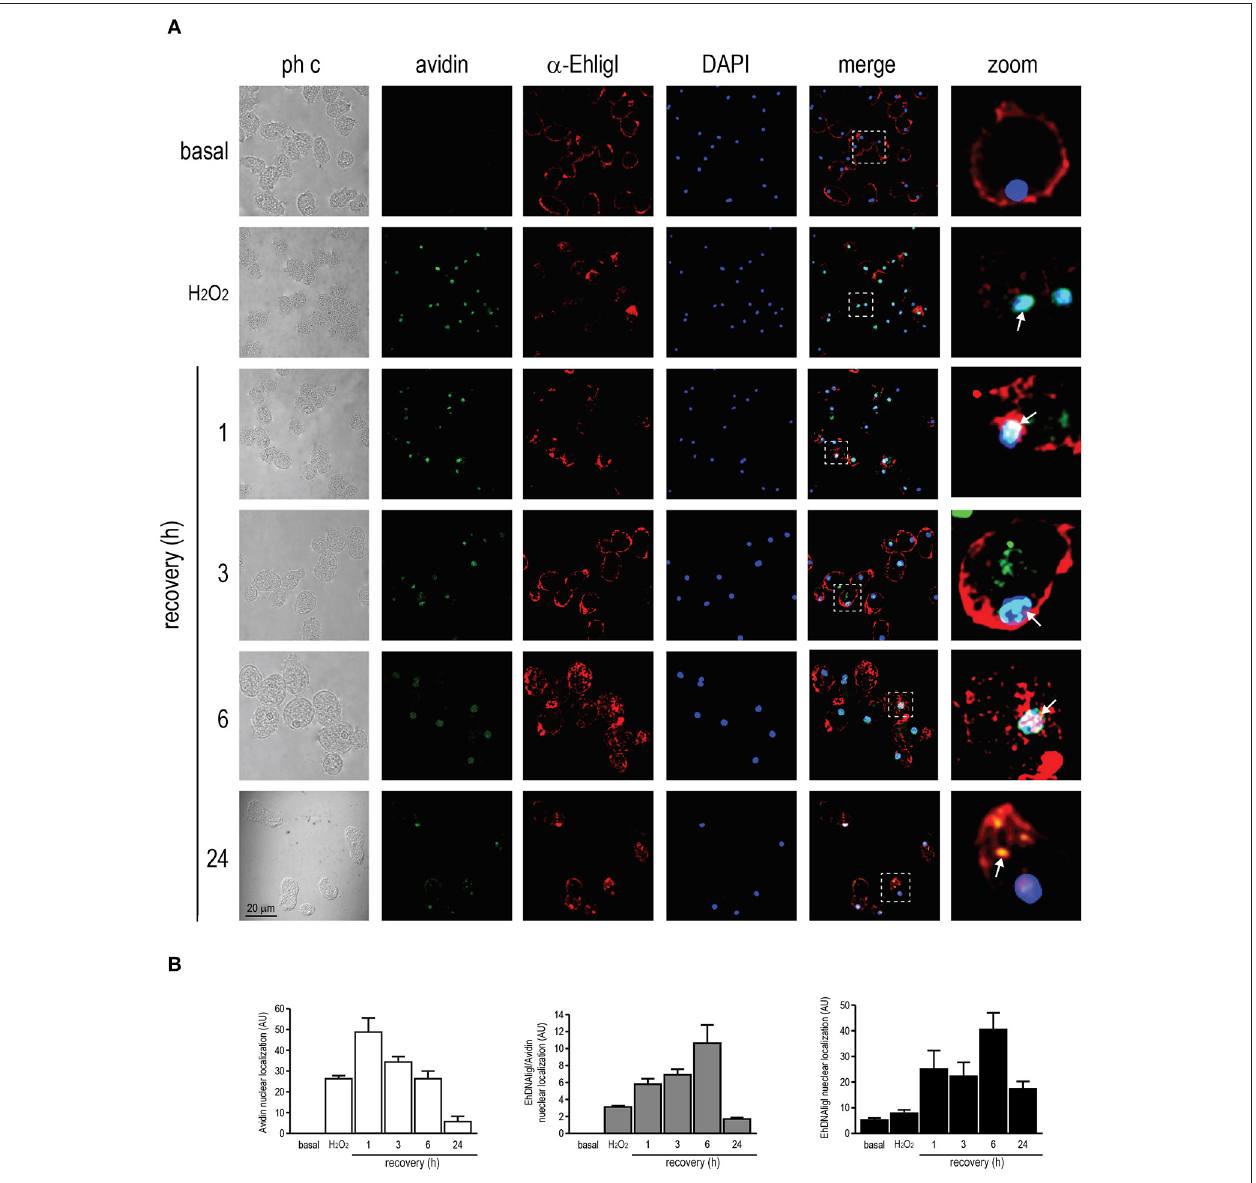
FIGURE 7 | Co-localization of EhDNAligI with the 8-oxoG adduct after H 2 O 2 treatment in E. histolytica trophozoites. (A) Immunofluorescence assays of trophozoites in basal condition, immediately or recovered at different times after treatment with H 2 O 2 (2.5mM for 1h). Trophozoites were incubated with avidin-FITC (Avidin) (green), and the α -EhDNAligI ( α -EhligI) antibody (red). Nuclei were counterstained with DAPI (blue). Merge: overlapping of fluorescent channels. Confocal microscopy images show a xy -section. ph c: Phase-contrast. Arrows: co-localization of EhDNAligI and avidin-FITC. Squares were magnified in right panels. (B) Quantification of green (Avidin), red (EhDNALigI) and green/red fluorescence channels using DAPI staining as reference for the cell number.